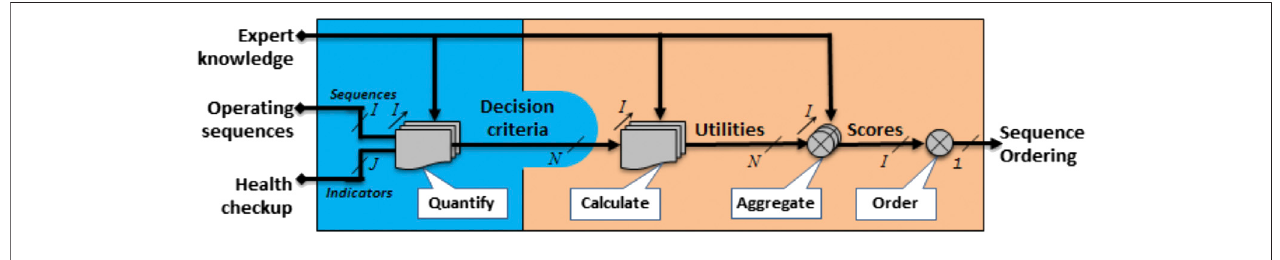
FIGURE 6 | Ranking